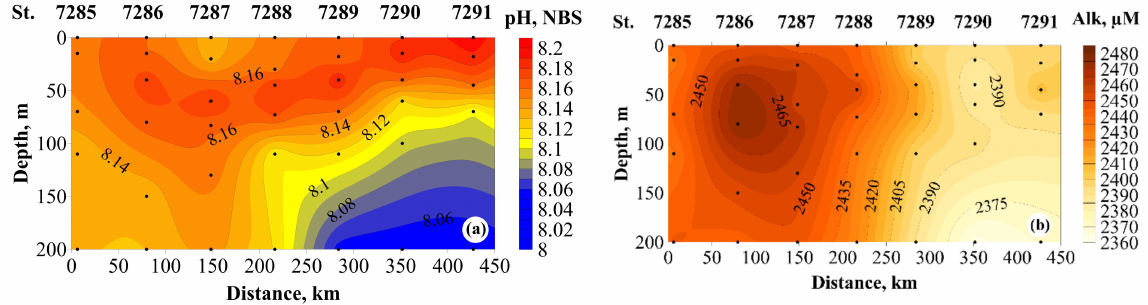
Figure 7. Distribution of pH (pH, NBS units) ( a ) and total alkalinity (Alk, µ M) ( b ) over the